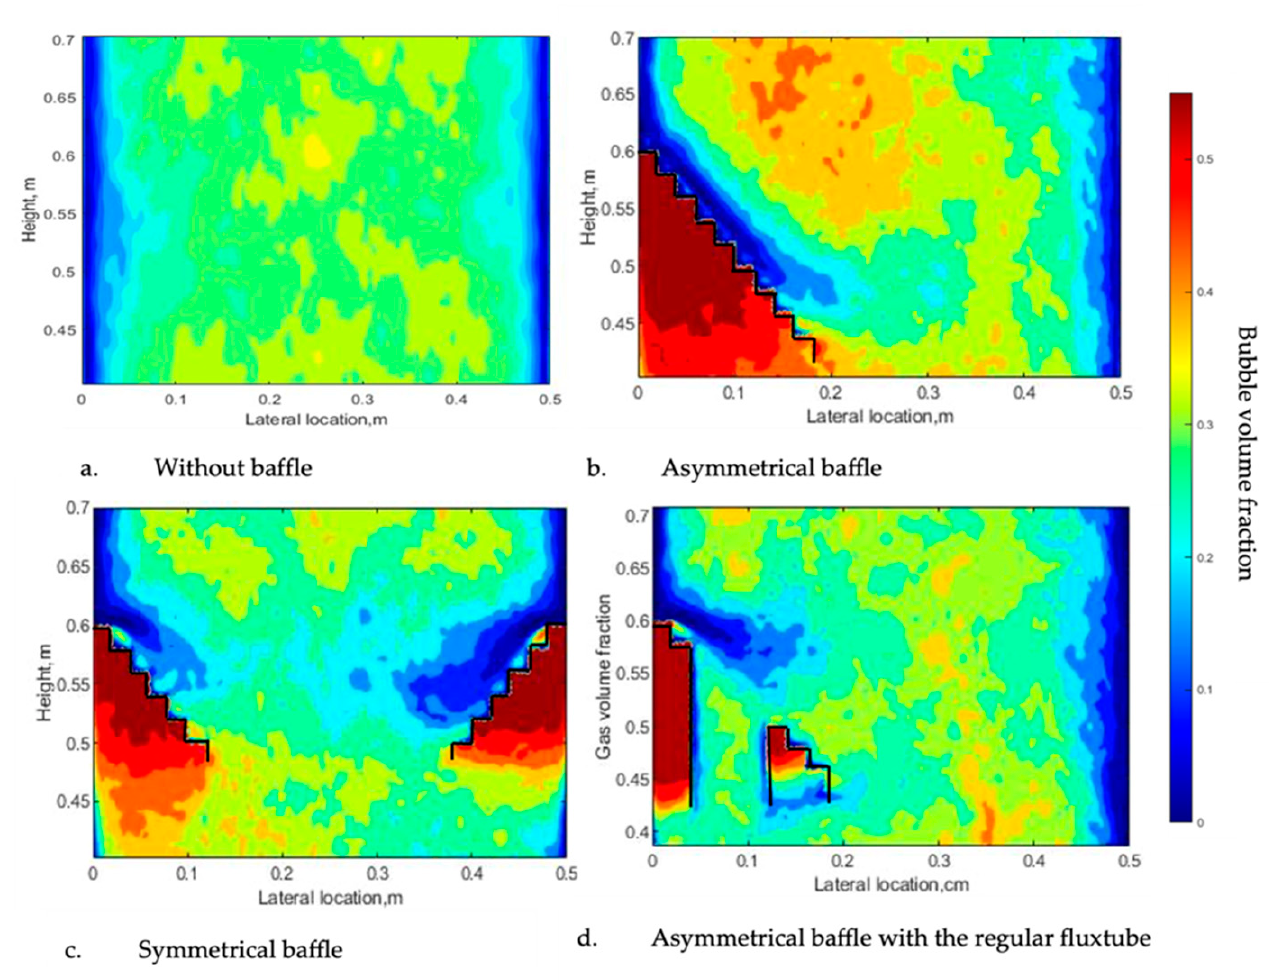
Figure 5. Bubble contours in the baffle zone (0.40 m < y < 0.70 m) with and without baffle and regular fluxtube under the superficial gas velocity of 0.4 m/s using the even gas inlet distributor